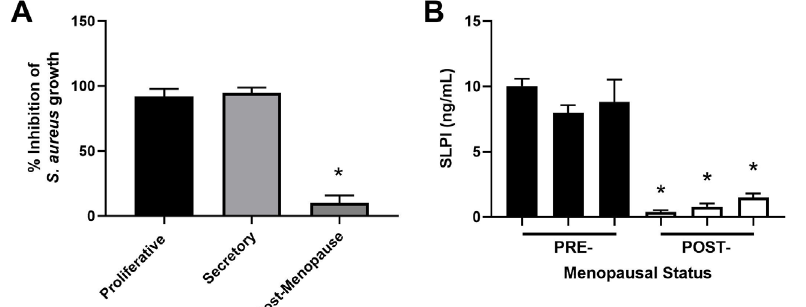
Figure 3. Antimicrobial activity and SLPI secretions by endometrial epithelial cells decrease following menopause. (A) S. aureus was incubated with apical secretions from polarized endometrial epithelial cells isolated from the proliferative ( n = 6), secretory ( n = 6), and post-menopausal ( n = 4) stages and bacterial growth subsequently determined; (B) apical secretions from pre- ( n = 3) and post- ( n = 3) menopausal women were analyzed for SLPI expression by enzyme-linked immunosorbent assay (ELISA). Data is shown as mean ± SEM. * P < 0.05; SEM: standard error of the mean. Data is derived from Fahey et al.